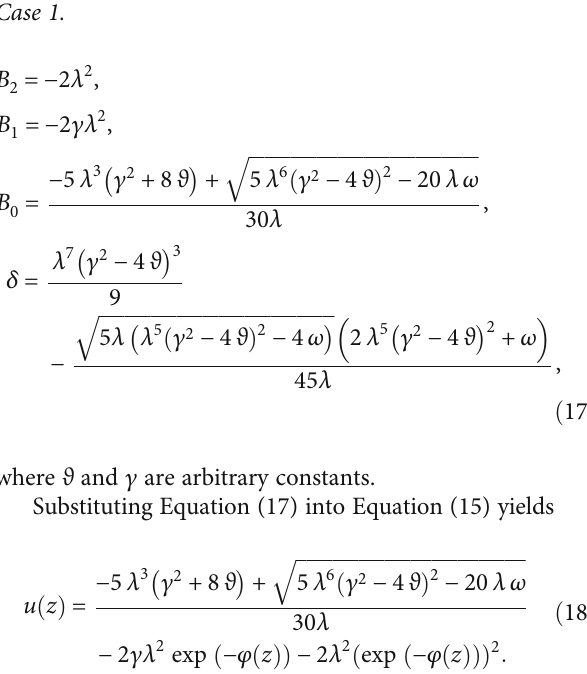
4 λ 2 γϑ p 4 ϑ − γ 2 p ffiffiffiffiffiffiffiffiffiffiffiffiffiffi tan 4 ϑ − γ 2